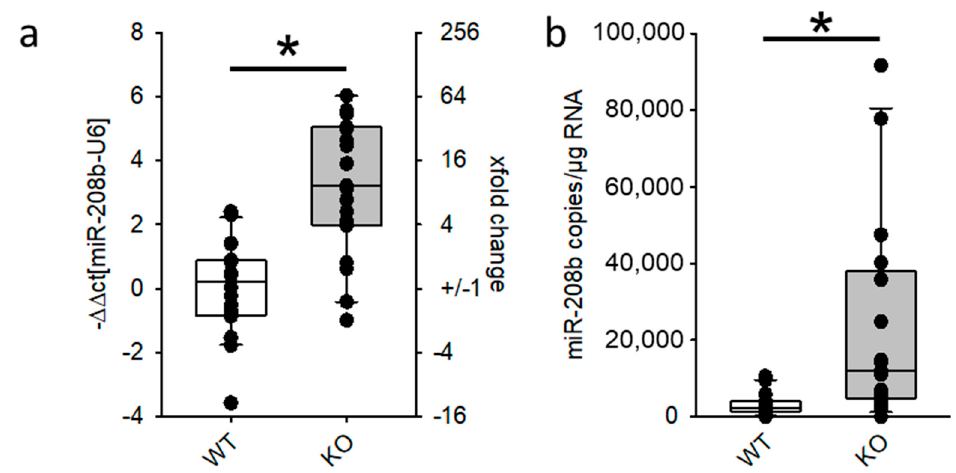
Figure 1. Expression of miR-208b in whole hearts from mice with severe heart hypertrophy. ( a ) Real-time qRT-PCR and ( b ) digital droplet PCR of male and female (N = 19–20 animals/group, * p ≤ 0.05 vs. WT).